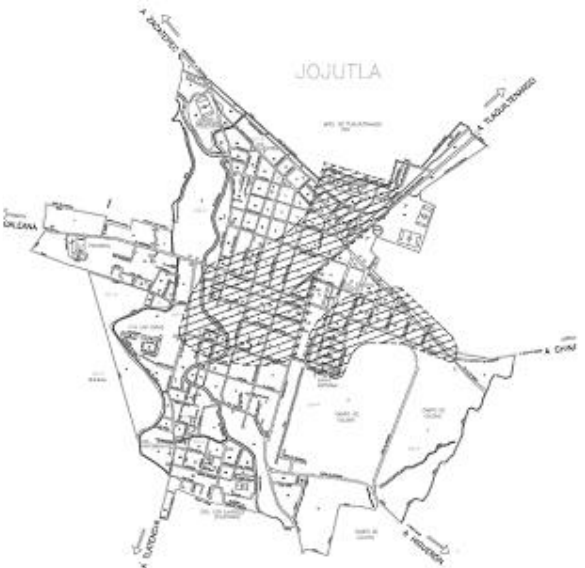
Figure 5. Seismic regionalisation of the 2017 Puebla earthquake in the town of Jojutla de Juárez, Morelos. Source: Jojutla Emergency Brigades (2017).